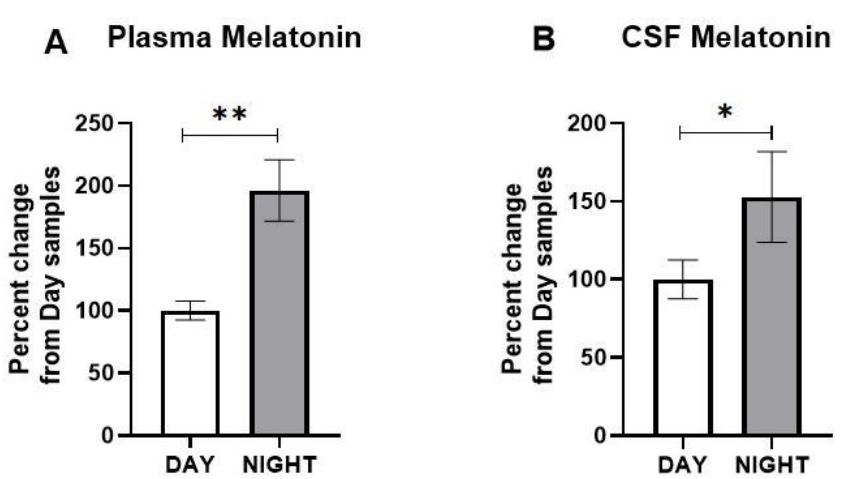
Figure 1. Melatonin concentrations during the day and at night in the ( A ) plasma and ( B ) cerebro- spinal fluid (CSF) of nonblasted rats. The results are expressed as means ± SEM ( n = 6), and the melatonin values of samples collected during daytime were compared to those collected at night (* p < 0.05 and ** p < 0.01).